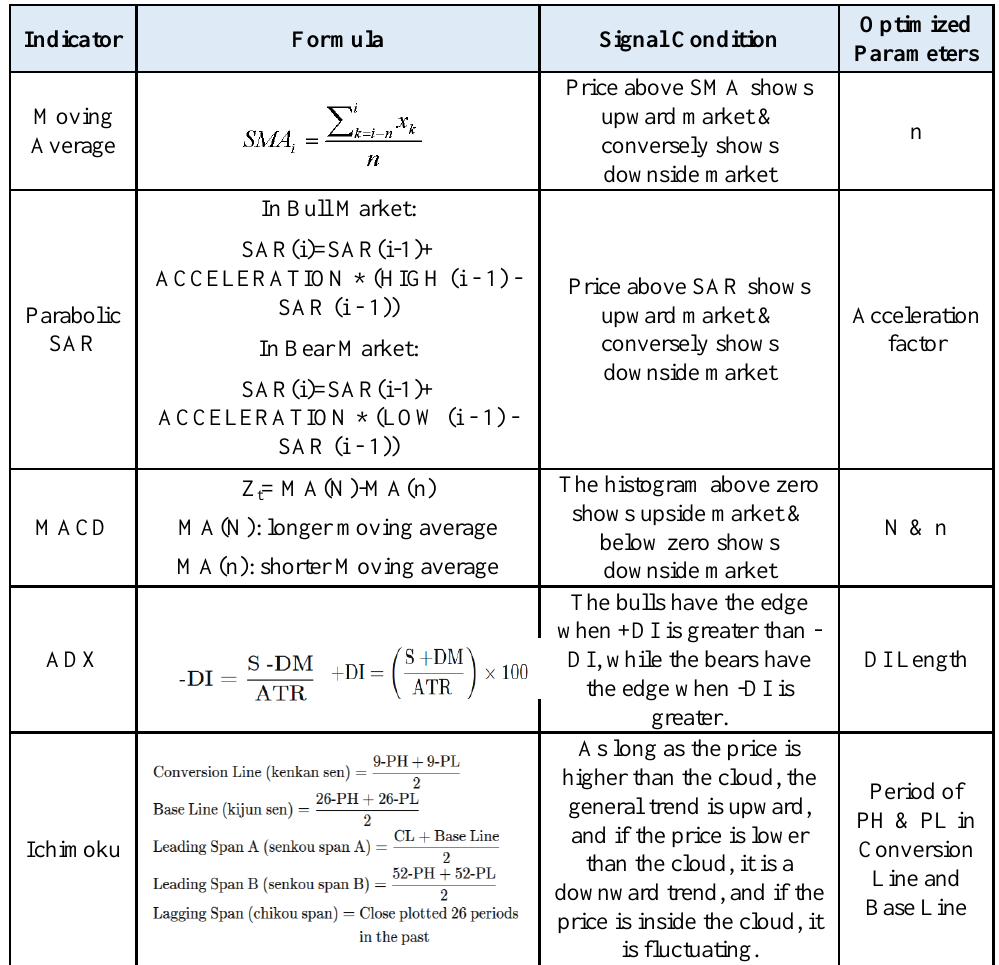
Table 1. Indicators list have been used in trending